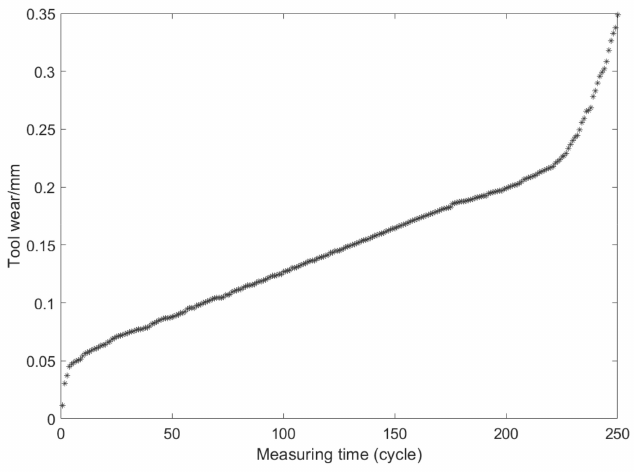
Figure 8. Tool-wearing